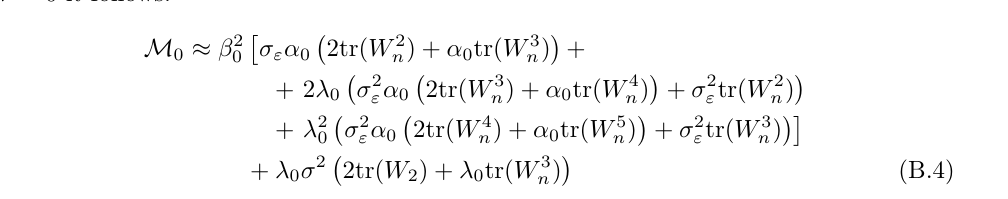
Figure B.1: Trace of powers of the spatial weights matrix (left) and simulated Moran’s I values (right). τ = 0 it